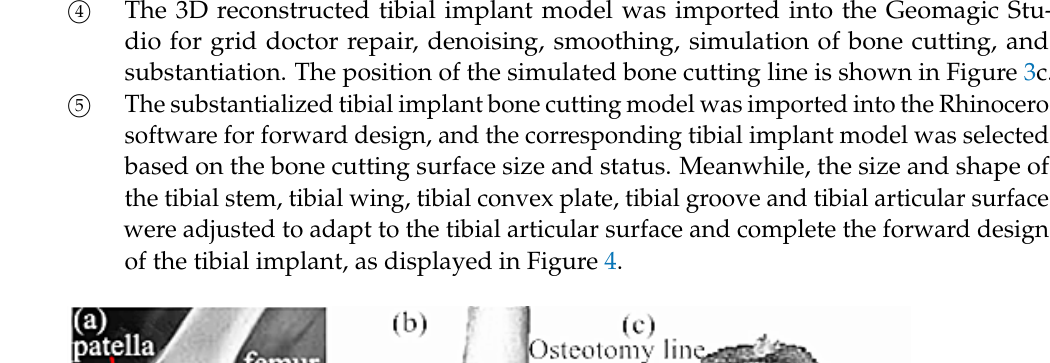
Figure 3. Reconstruction of reverse osteotomy of tibial implants: ( a ) CT image of knee joint; ( b ) Post reconstruction effect; ( c ) Bone cutting surface selection.